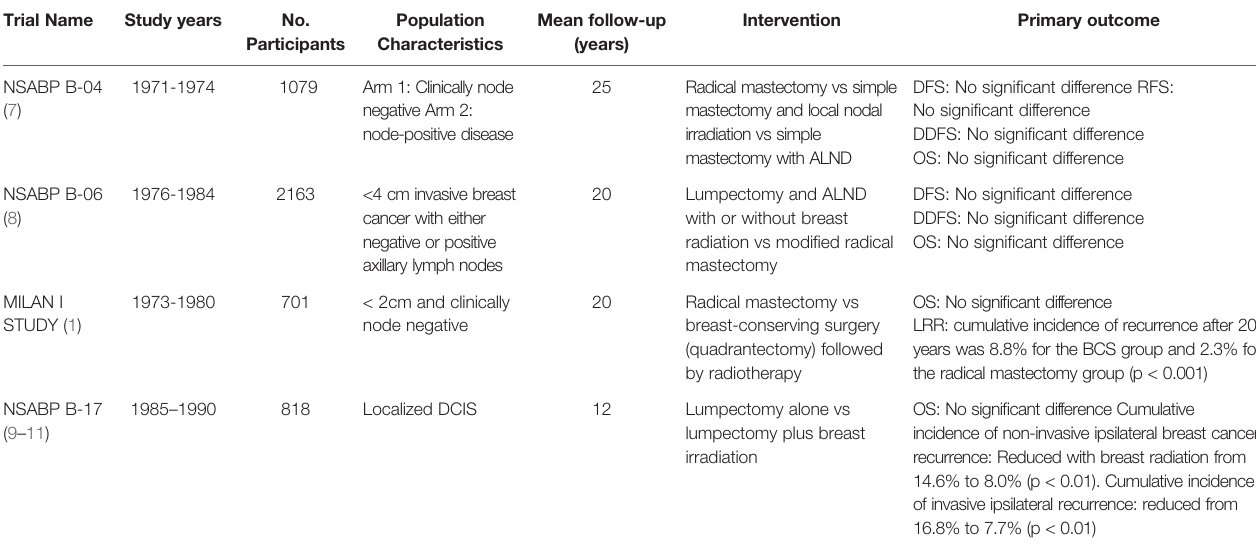
TABLE 1 | Landmark RCT in the surgical management of non-invasive and invasive breast